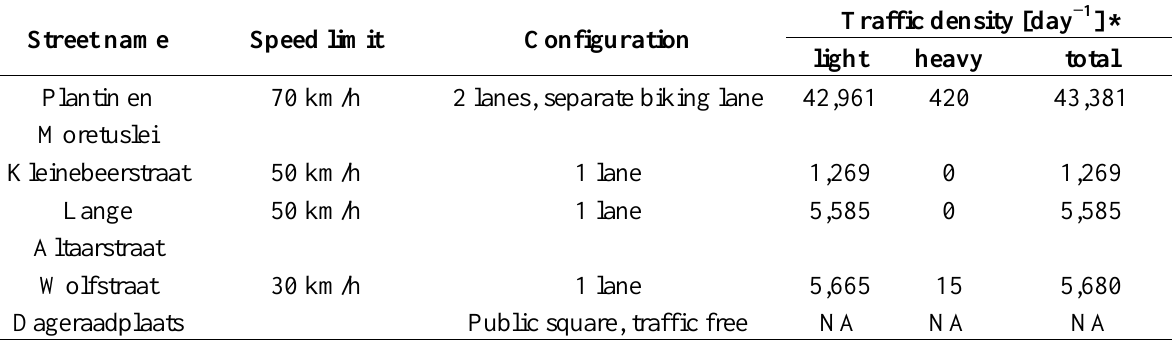
Table 2. Description of some street characteristics along the monitoring